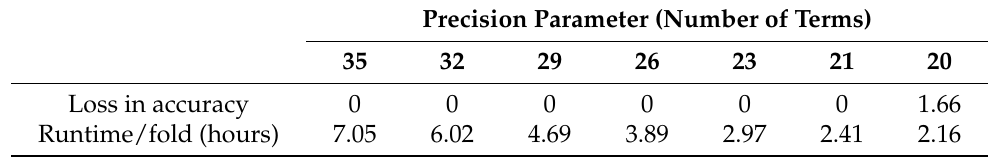
Table 3. Influence of the precision parameter on the loss of accuracy and on the computational time for the EEG-based seizure detection use